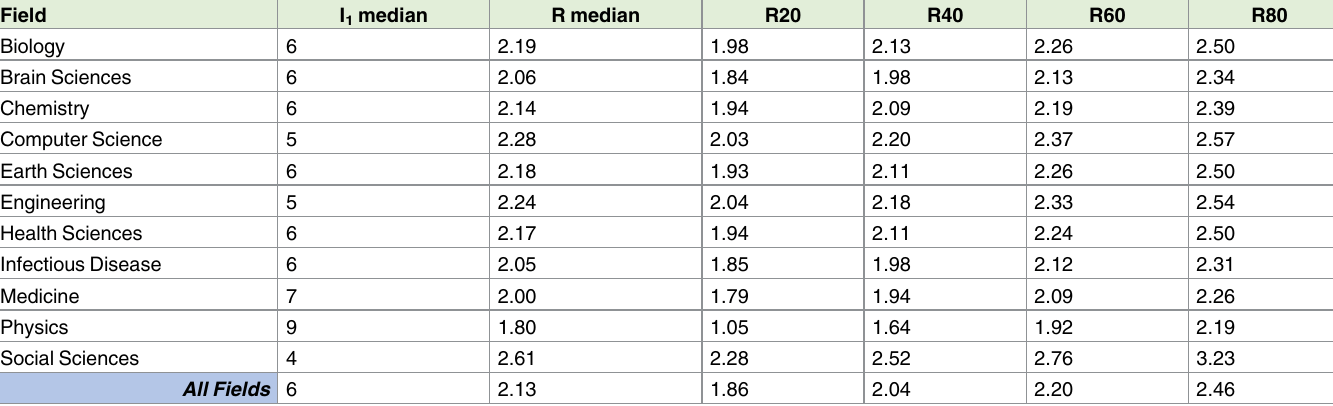
Table 1. Median of I 1 values, and median/percentiles of R values in 2015across all researchers, separated by researchfield. This data was obtained using the full set of